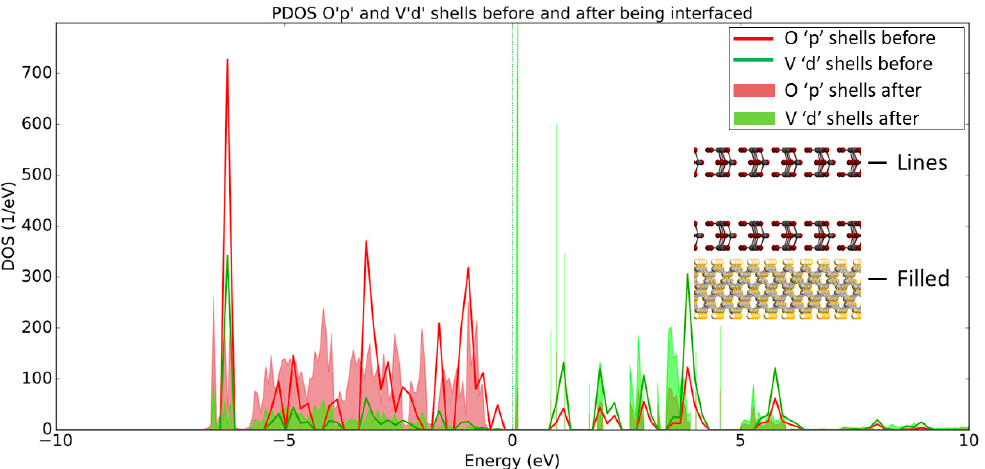
Figure 10. PDOS plot of O p and V d shells before (lines) and after (filled) being interfaced with the H-diamond. Inset are 2D crops of the systems being shown in the PDOS, showing that the line and filled plots denote the MoO 3 before and after being interfaced, respectfully.